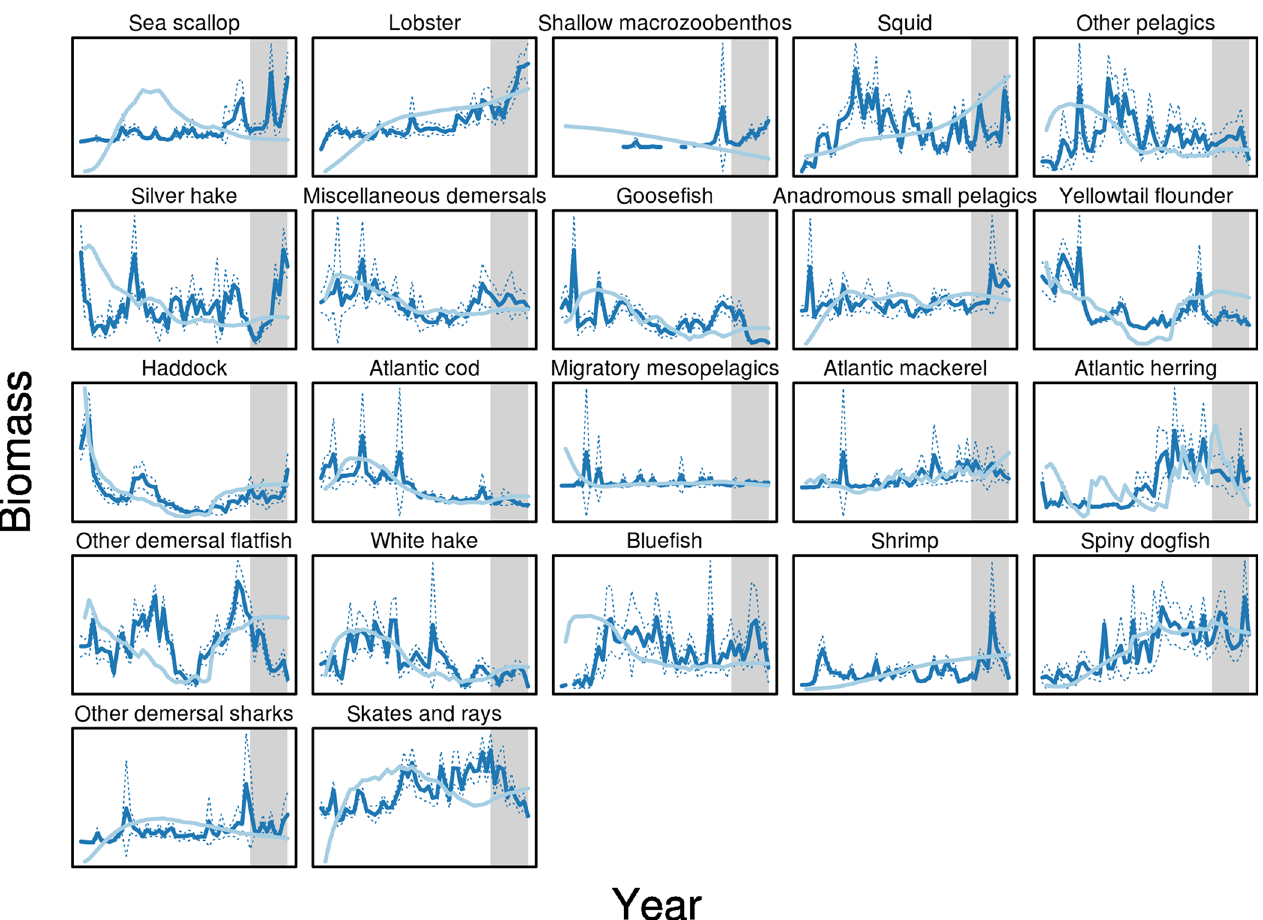
Fig 3. Biomass (normalized) time series. Survey data time series (dark blue) with 95% confidence interval bands (dotted lines) versus Atlantis model biomass predictions (light blue). Gray area indicates the forecast time-period from 2004 – 2013. We label (and color code) the data-categories Biomass (blue), Landings (orange), and Indicators (green), consistently throughout the results